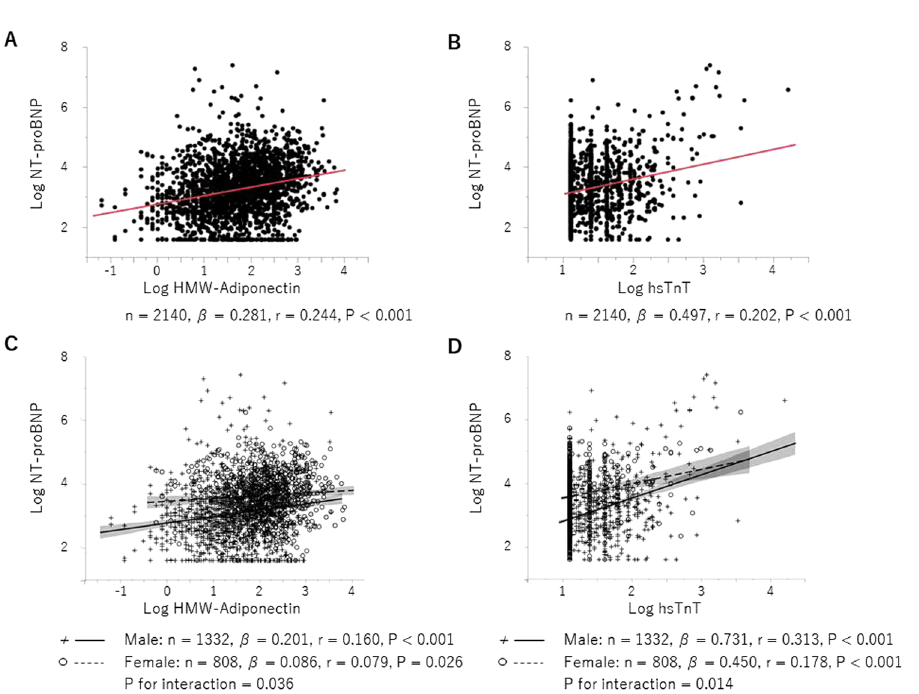
Figure 3. Correlations between NT-proBNP and HMW-adiponectin ( A and C ) or hsTnT ( B and D ). Significant sex differences were evident in the correlations ( C and D